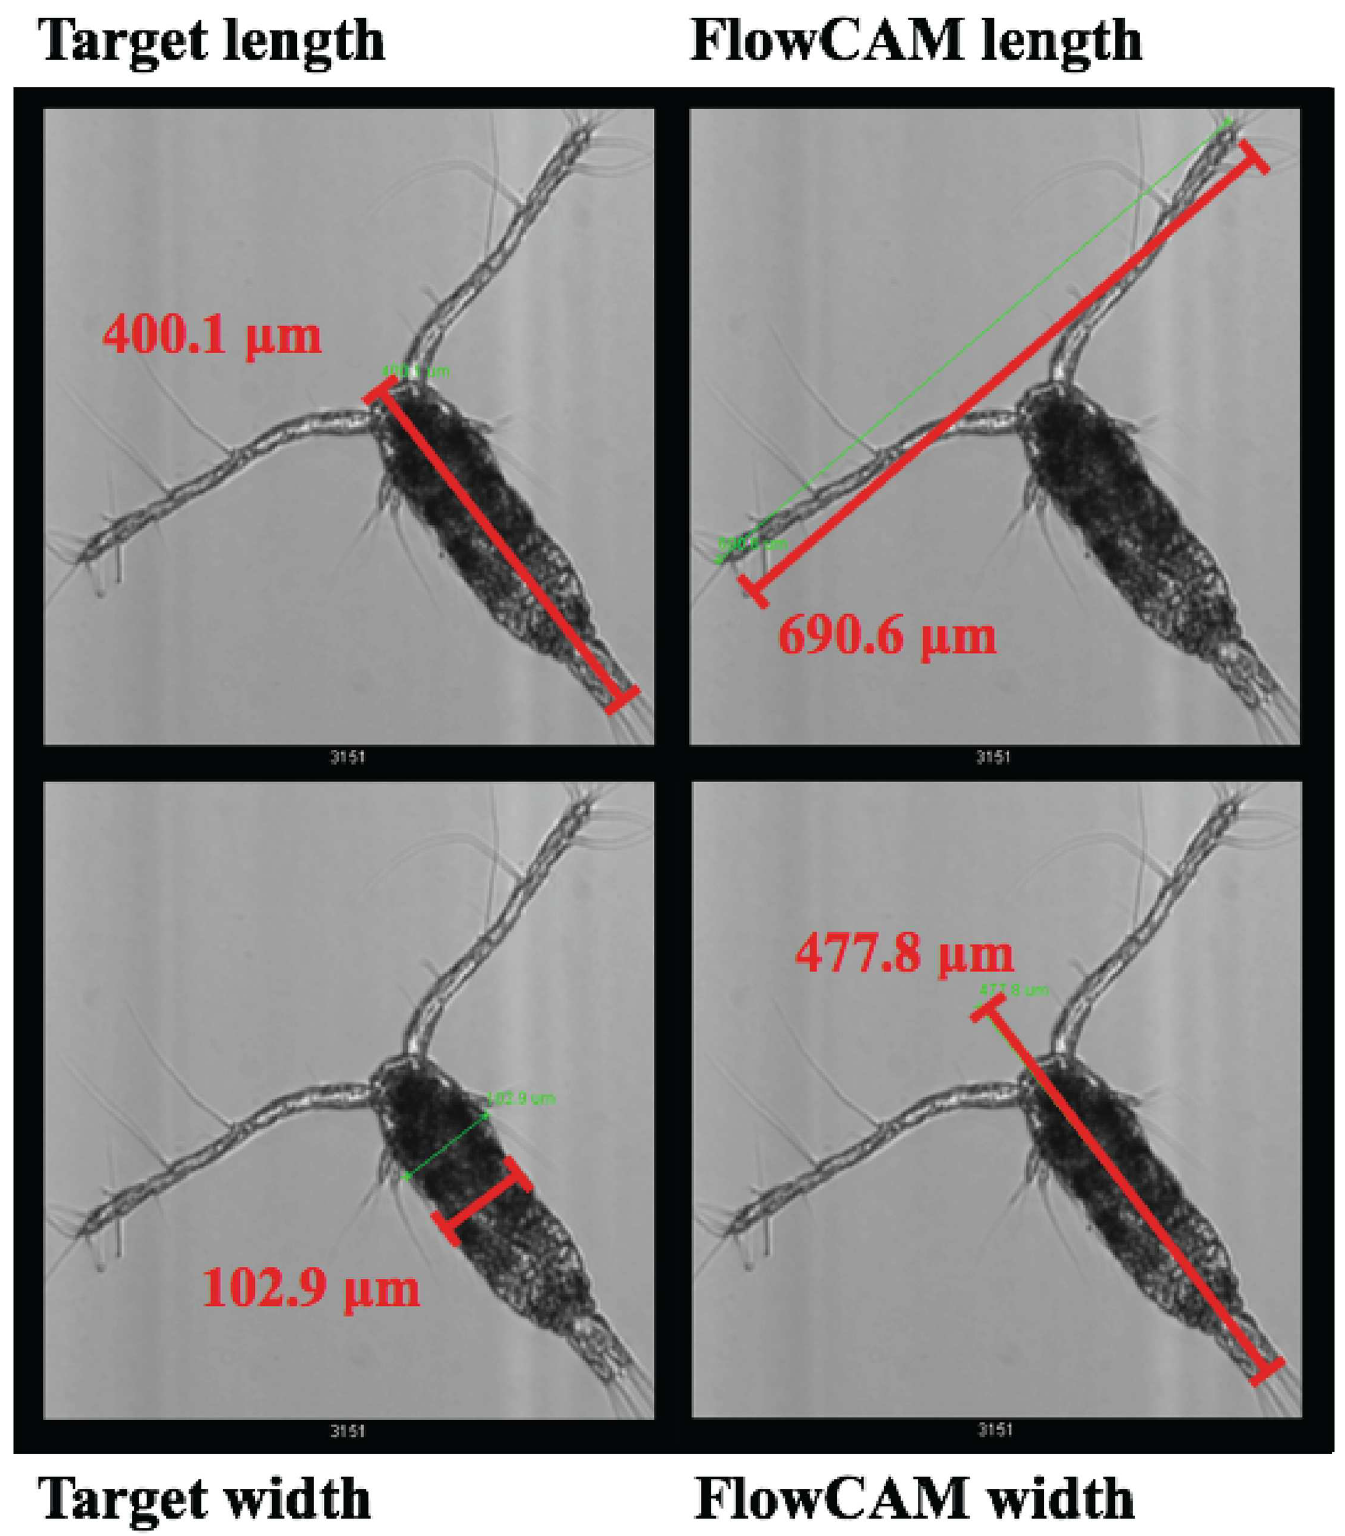
Fig 4. Example illustrating the inconsistency between the target length and width versus the FlowCAM image-based length and width. The target length and width of the copepodin this image are 400.1 and 102.9 μ m respectively.However, the actual length and width FlowCAM measuredare 690.6 and 477.8 μ m respectively,which are affected by the extendedcopepodantenna.